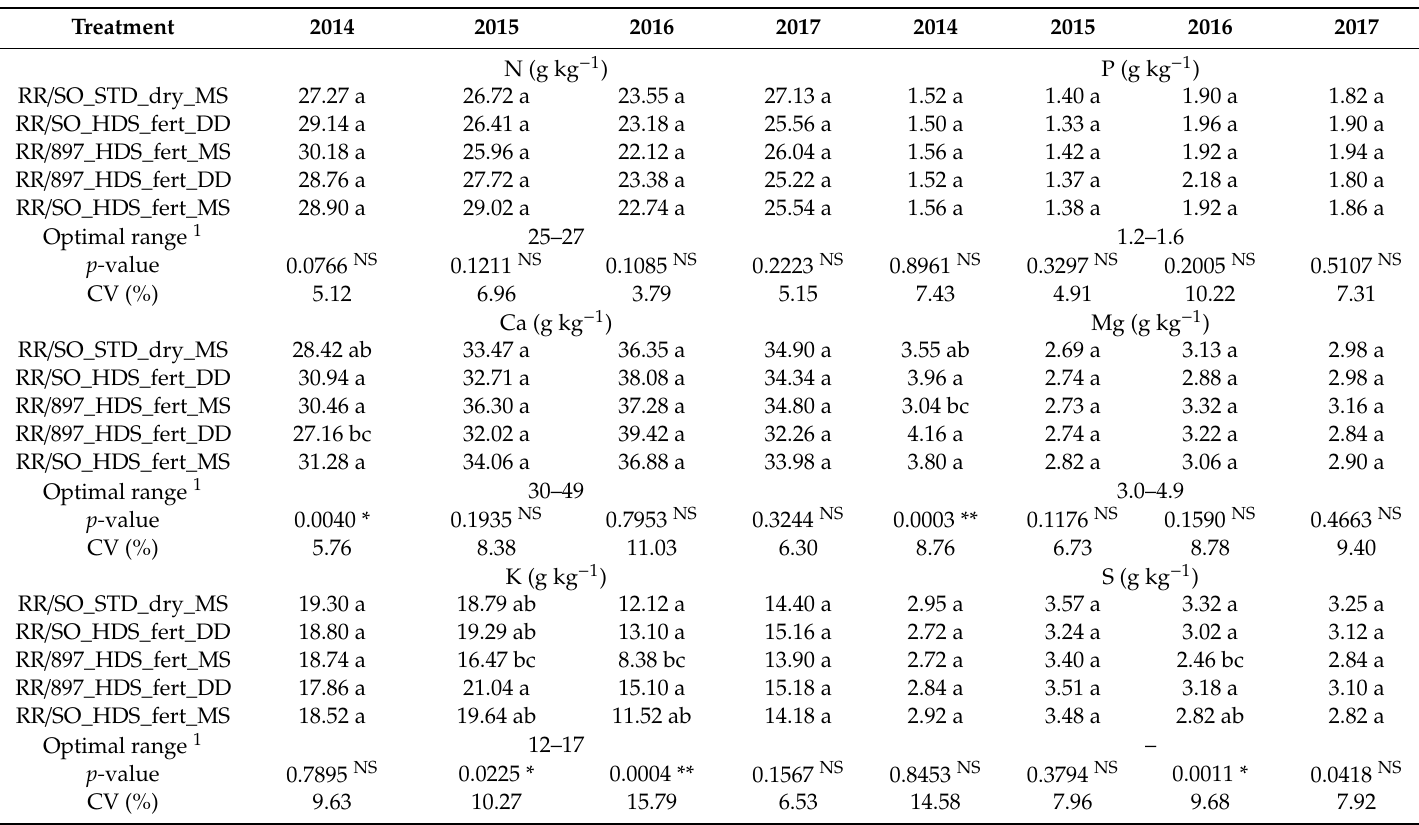
Table 1. Foliar macronutrient concentration of “Ray Ruby” grapefruit trees (RR) as a function of treatments applied during the experimental period